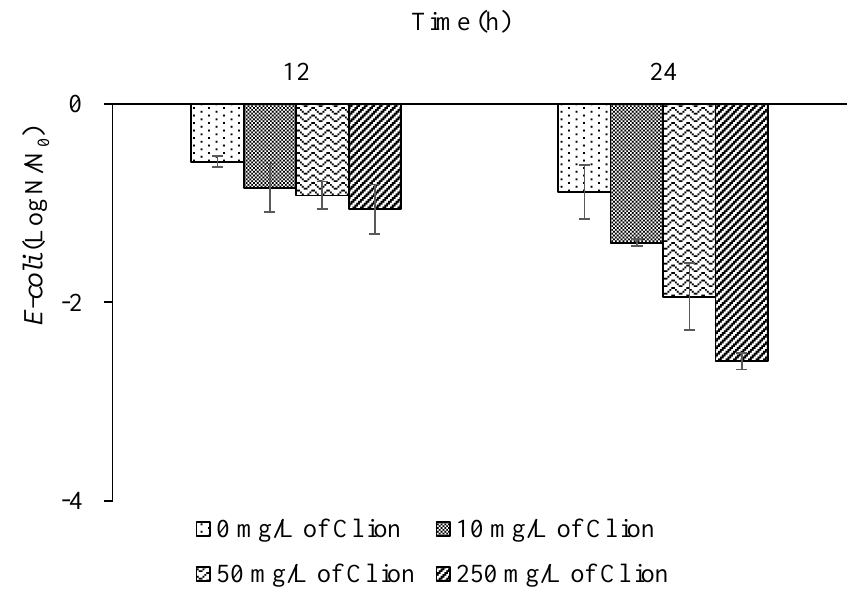
Figure 7. Disinfection of E. coli by copper embedded ceramic cubes after 12 and 24 h contact times. Error bars represent standard error.